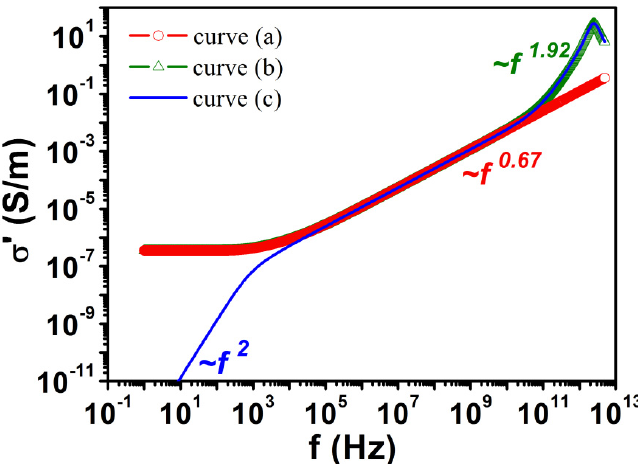
Figure 1. Simulation curves according to Equation (9) with parameter values: σ ο = 3.48 × 10 − 7 S/m, α = 1, β = 0.32, Δε = 4.63, f HN = ω ΗΝ /2 π = 637 (Hz), γ /2 π = 2 × 10 12 (Hz), A/(2 π ) 2 = 1 × 10 24 (Hz 2 ) and ω ο /2 π = 2.5 × 10 12 (Hz). ( a ) Simulation curve of Equation (16) with k = l = 1 and m = 0. ( b ) Simulation curve of (16) with k = l = m = 1. ( c ) Simulation curve of Equation (9) with k = 0 and l = m = 1.